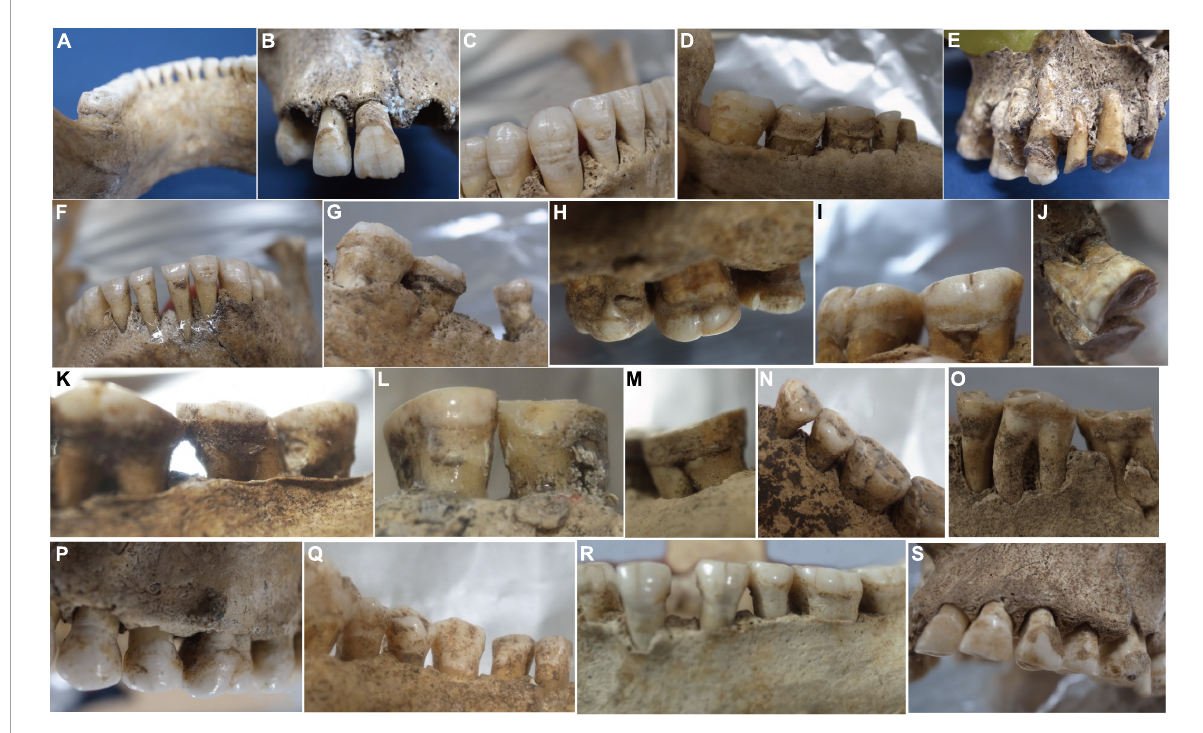
FIGURE2 Conditions of dental calculus on the sampled human bone remains. (A) , ID 1; (B) , ID 1; (C) , ID2; (D) , ID 3; (E) , ID 4; (F) , ID 5; (G) , ID 6; (H) , ID 7; (I) , ID 8; (J) , ID 9; (K) , ID 9; (L) , ID 10; (M) , ID 10; (N) , ID11; (O) , ID 12; (P) , ID 13; (Q) , ID 14: (R) , ID 15; (S) , ID 16.